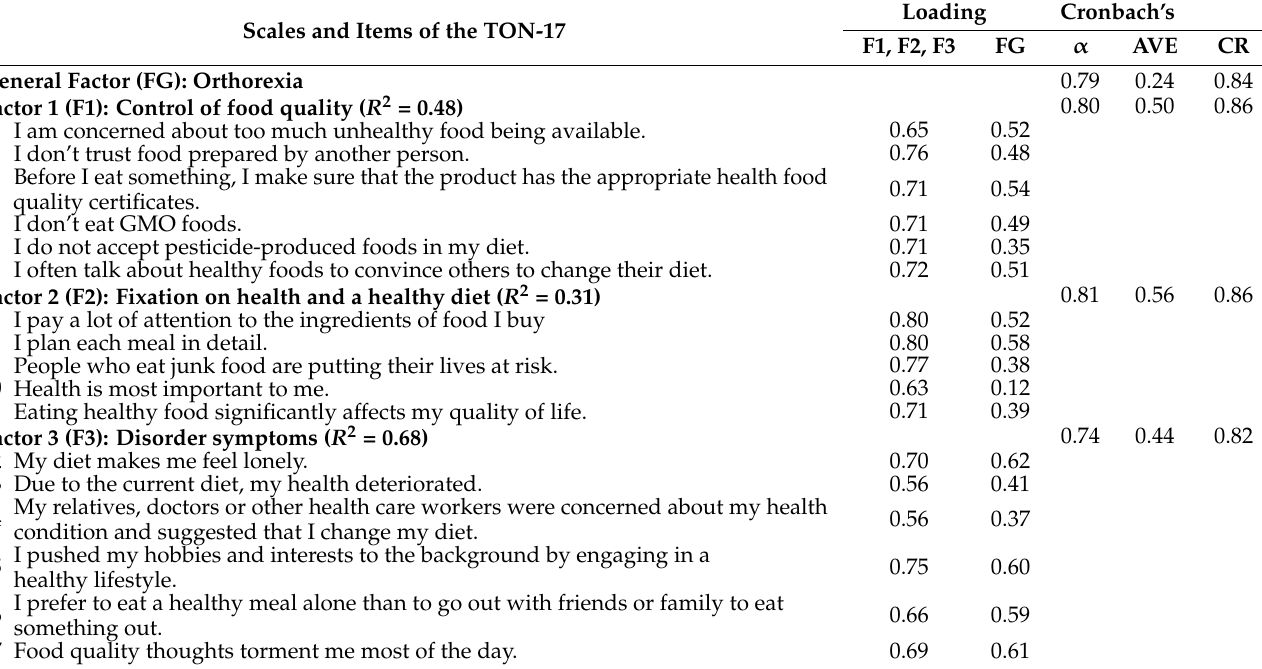
Table 3. The composite construct analysis